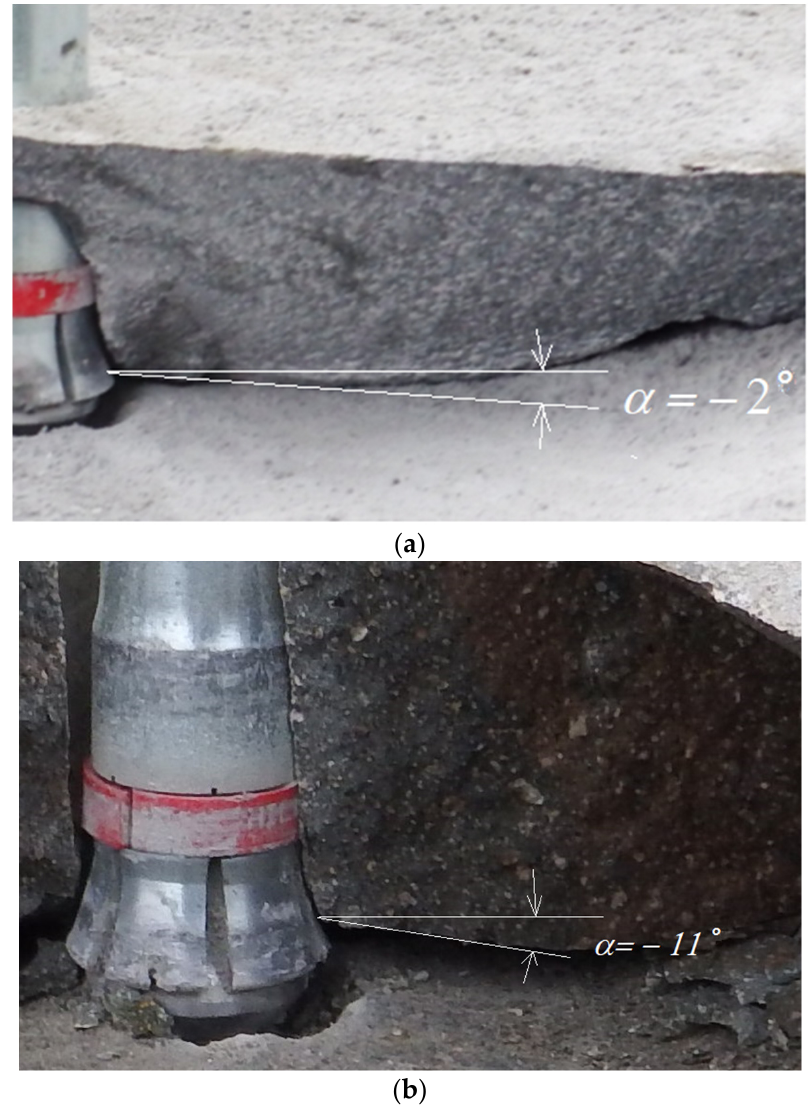
Figure 12. Initial propagation angle: ( a ) anchor head in early life β = 28° and ( b ) anchor head in advanced stage of wear, β = 19°, torn-off carbide reinforcement elements.